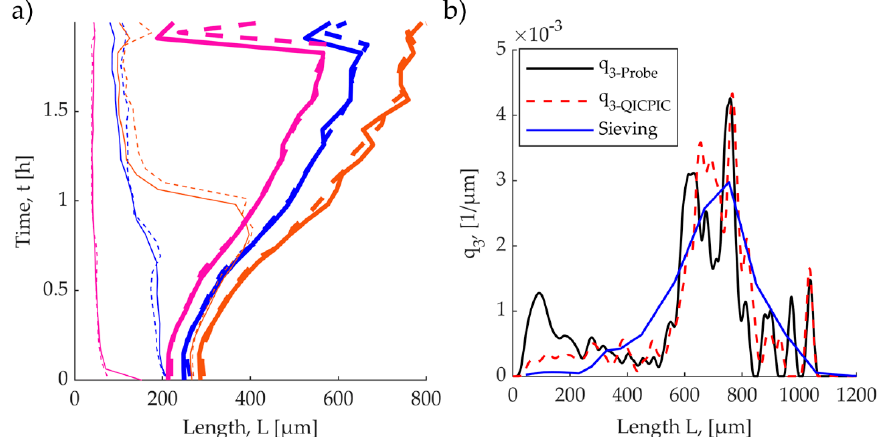
Figure A7. ( a ) Percentiles and mean values of the crystal size distributions for Exp. 2—KH 2 PO 4 thin lines —percentiles of the q 0- distribution; bold lines —percentiles of the q 3 -distributions; Solid lines —percentiles and mean values shadowgraphic probe; Dashed lines—percentiles and mean values QICPIC; brown; magenta − 0.15 and 0.85 percentile of the corresponding distribution; blue —mean size of the corresponding distribution. ( b ) Comparison of the mass distribution: shadowgraphic probe, QICPIC, sieve analysis.